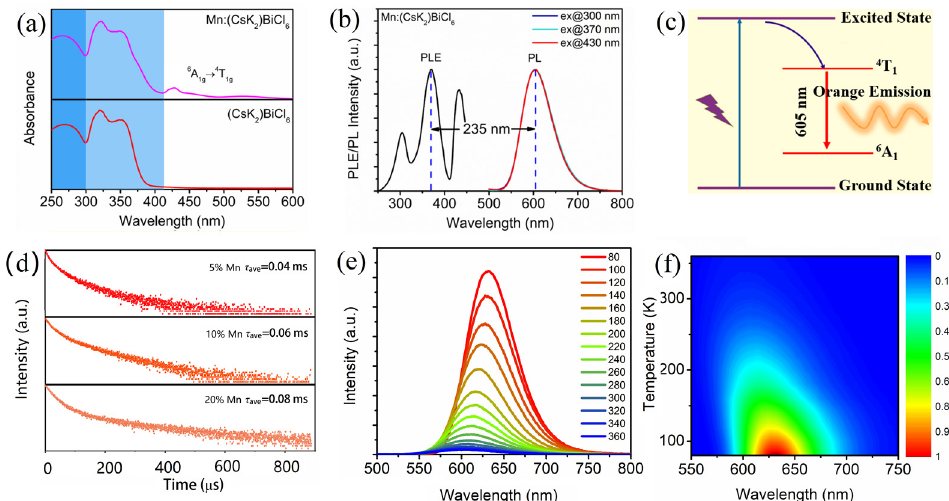
Figure 5. ( a ) The absorption spectra of (CsK 2 )BiCl 6 and Mn:(CsK 2 )BiCl 6 . ( b ) The PL and PLE spectra of (CsK 2 )BiCl 6 . ( c ) The energy transfer diagram of Mn-doped (CsK 2 )BiCl 6 . ( d ) Time-resolved PL (TR- PL) spectra of (CsK 2 )BiCl 6 with different Mn 2+ doping concentrations. ( e ) Temperature-dependent PL spectra of Mn:(CsK 2 )BiCl 6 . ( f ) Pseudo color mapping of temperature-dependent PL intensity and wavelength.